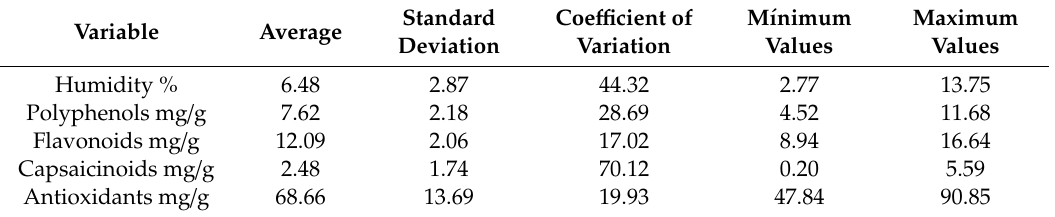
Table 8. Average, standard deviation, coe ffi cient of variation, minimum and maximum values for the characteristics of the nutritional value of 15 accessions of chilli ( Capsicum spp.).